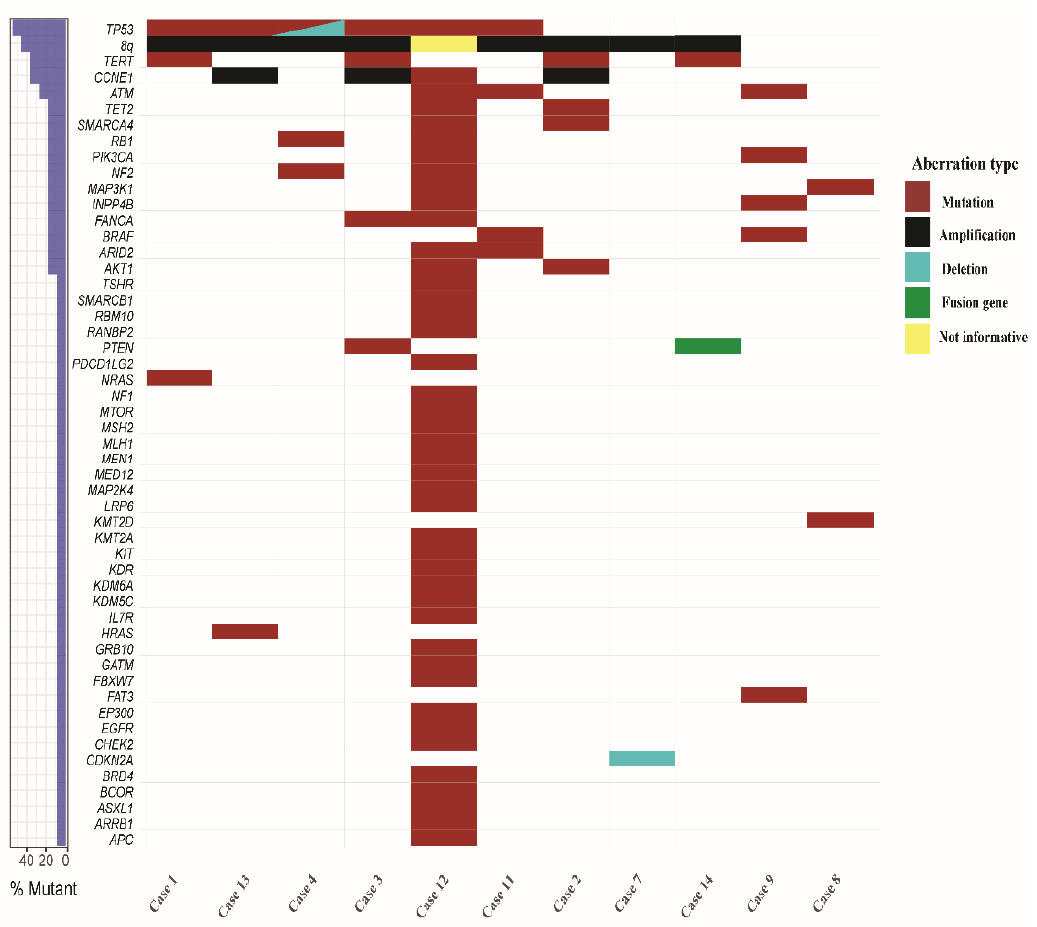
Figure 2. Genomic landscape of 11 cases of anaplastic thyroid cancer investigated by whole exome sequencing.